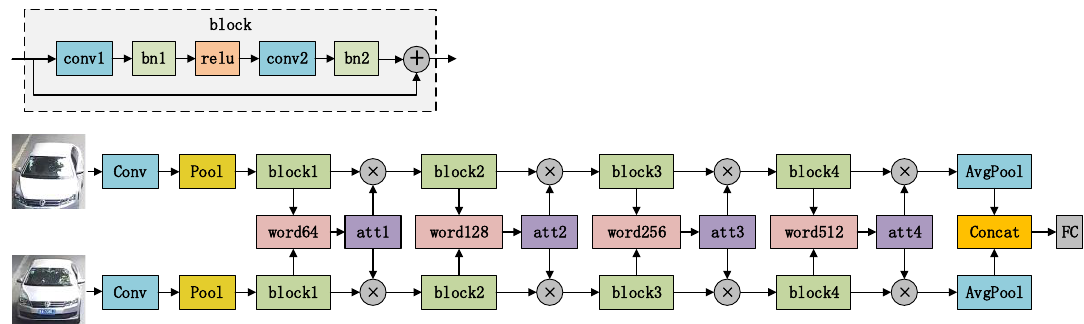
Figure 3. Overall framework of the proposed method. The simplest version of ResNet is selected as the main body of the two branches. The block indicates a deep residual structure in the dotted line. A soft attention model is appended after each block for feature location (att1, att2, att3, att4). The word vectors for each block have different lengths (word64, word128, word256, word512) according to hierarchical feature channels.